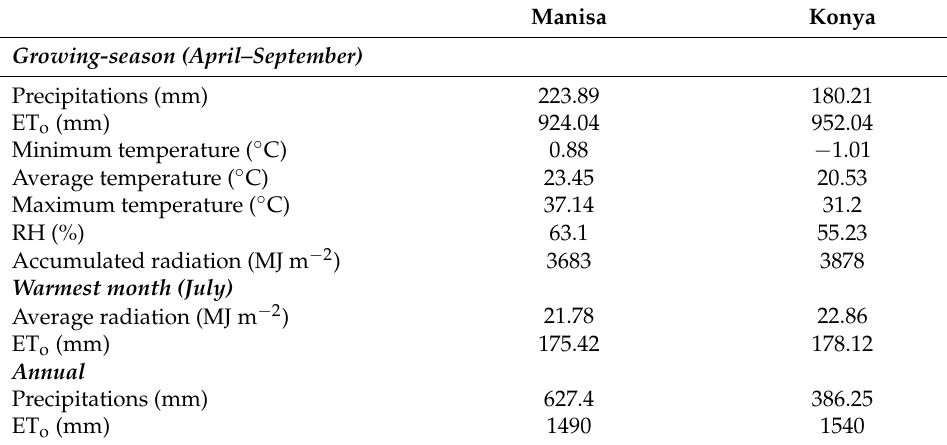
Table 1. Climatic information of the Manisa Viticulture Research Institute (Manisa) and Selçuk University (Konya) in the 2020